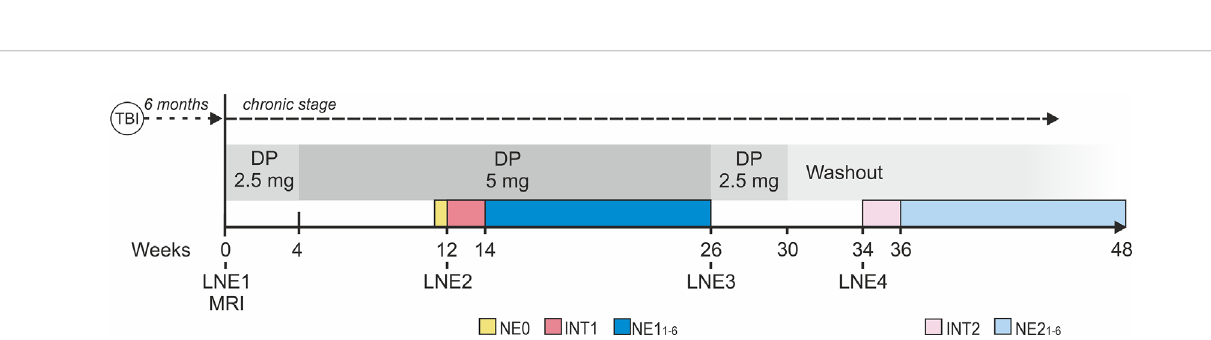
FIGURE 1 | Structural magnetic resonance imaging (MRI) in the acute stage. A MRI (T2-weighted, and FLAIR sequences) was performed 4 days after traumatic brain injury, showing a marked communicating hydrocephalus with transependymal edema and a large area of contusion in the left lateral temporal lobe extending into the parahippocampal gyrus. Axial slices in native space are shown. L, left;